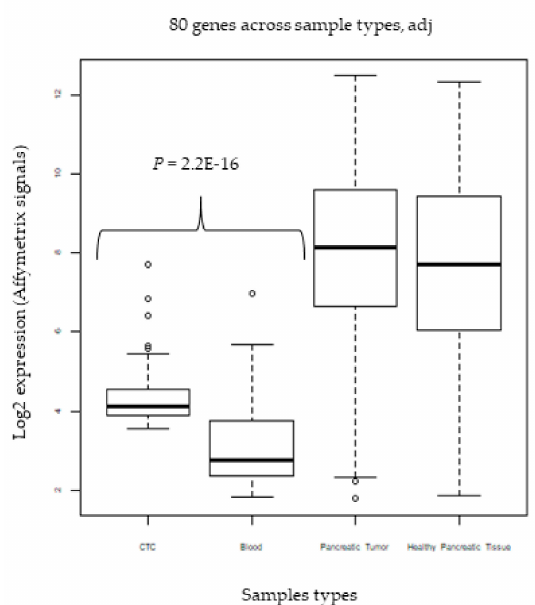
Figure 6. Boxplots showing the average expression levels of the 80 genes for each specimen group. Levels of expression of the 80 genes in the analyzed species of the study GSE18670, which consisted of CTCs, hematological cells, original tumor, and non-tumor pancreatic control tissue of patients with pancreatic ductal adenocarcinoma. High levels of expression, greater than 6 (log2), can be noted for tumor and non-tumor tissue. For CTCs, this level of expression was higher than 4, whereas for blood, these levels were less than